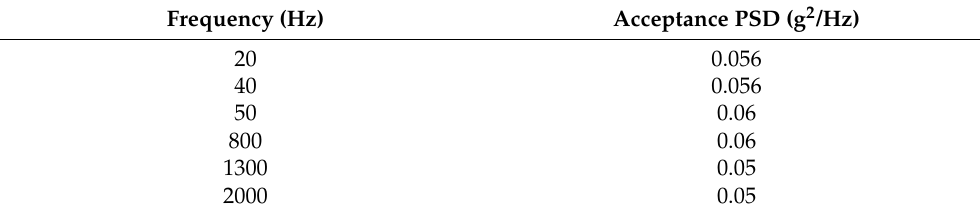
Table 2. Random vibration loading PSD values.